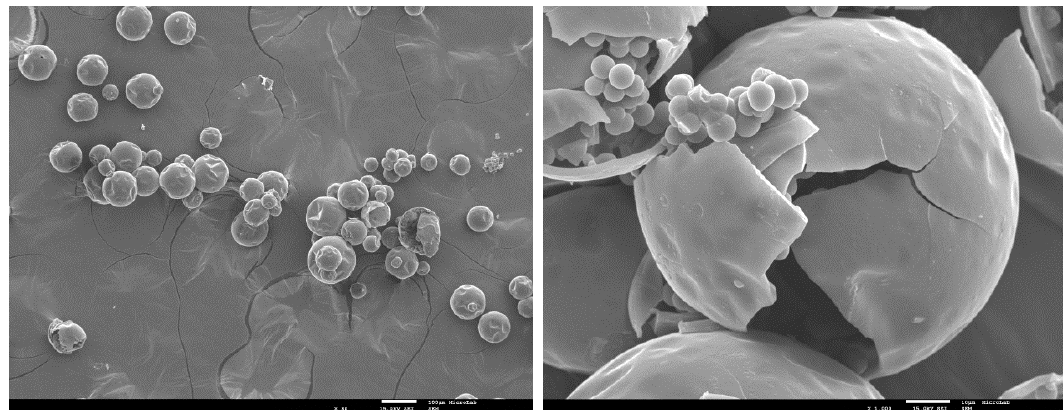
Figure 4. SEM image of I MCs (Active H and NCO source: isocyanato silane, IPES). The image on the right displays a broken MC which demonstrates the core–shell morphology typical of these MCs. Scale bar = 10 μ m.